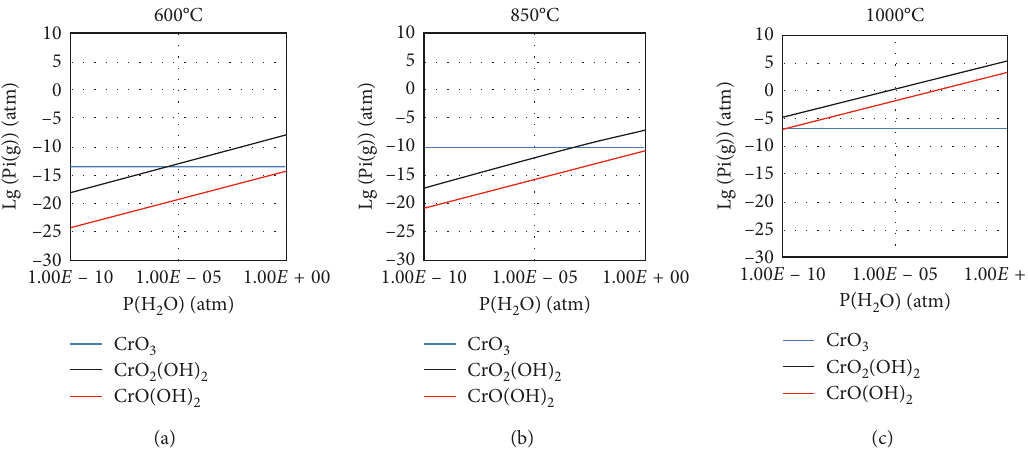
Figure 5: Partial pressures of chromium vapor species varying with the partial pressure of H 0.209 atm (partial pressure of oxygen in air). (b) 850 ° C; (c) 1000 ° C. Wherein, P(O 2 ) (cid:31)